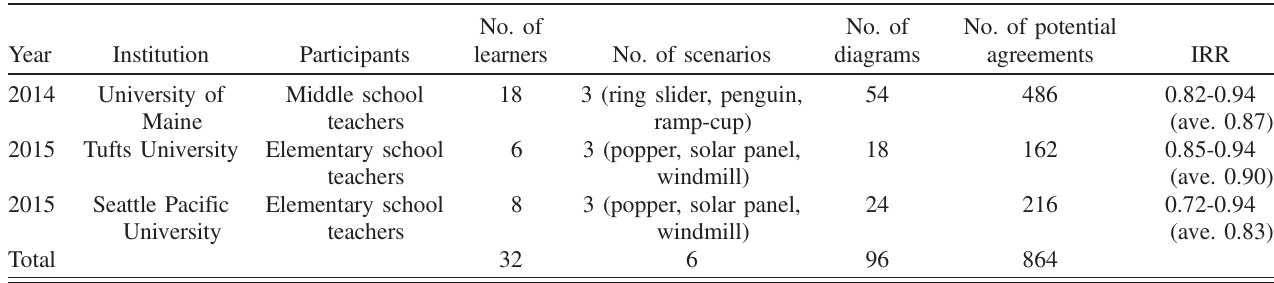
TABLE VI. Reliability data for energy diagram checklist.